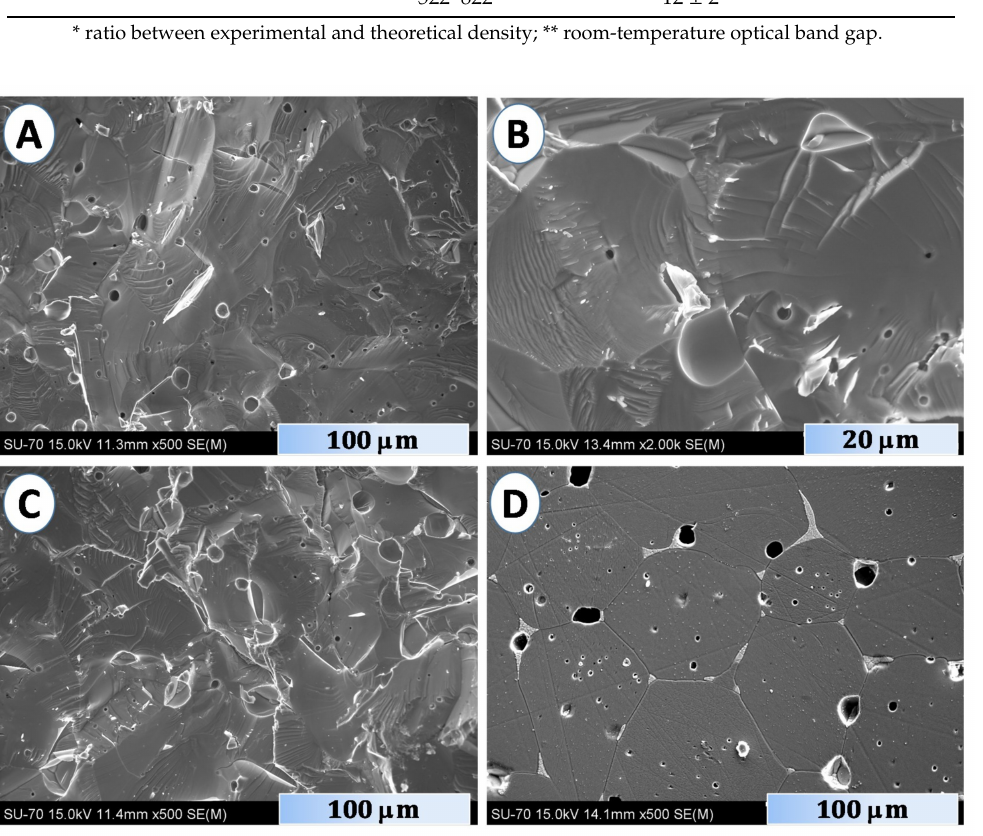
Figure 3. SEM microstructures of the fractured ( A – C ) and polished ( D ) ceramic samples with